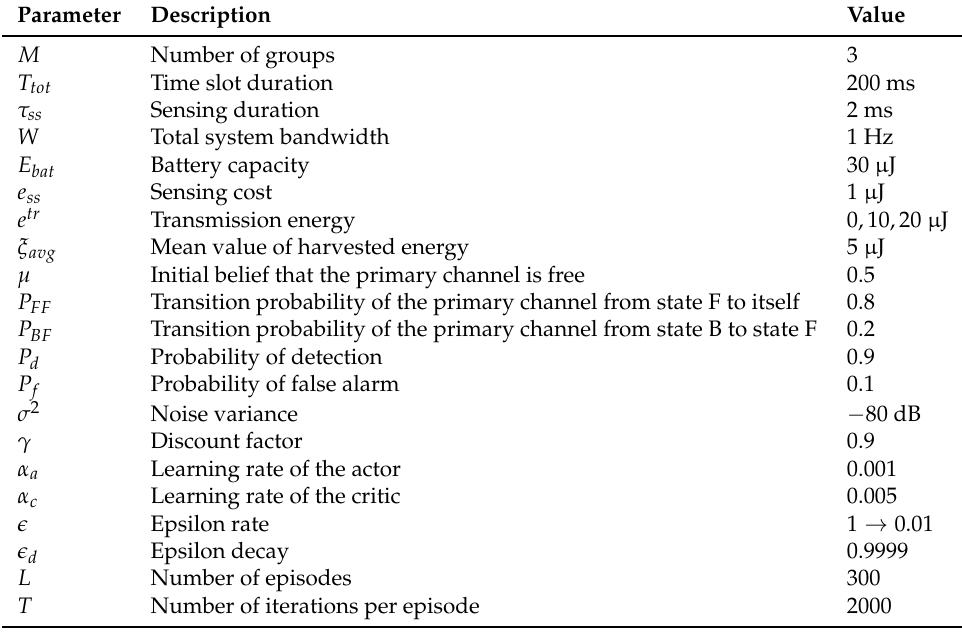
Table 1. Simulation Parameters.